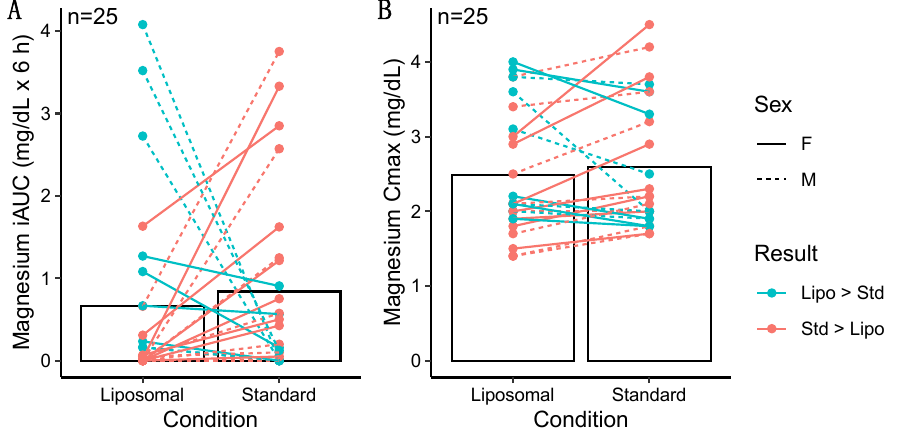
Figure 5. Individual differences in incremental area under the curve (iAUC; panel A ) and maximal observed concentration (Cmax; panel B ) values for magnesium. Magnesium iAUC values ( p = 0.30 via Wilcoxon signed-rank test) and Cmax values ( p = 0.41 via paired samples t -test) did not differ between conditions. Individual responses are represented by lines, and bars represent mean values in each condition.